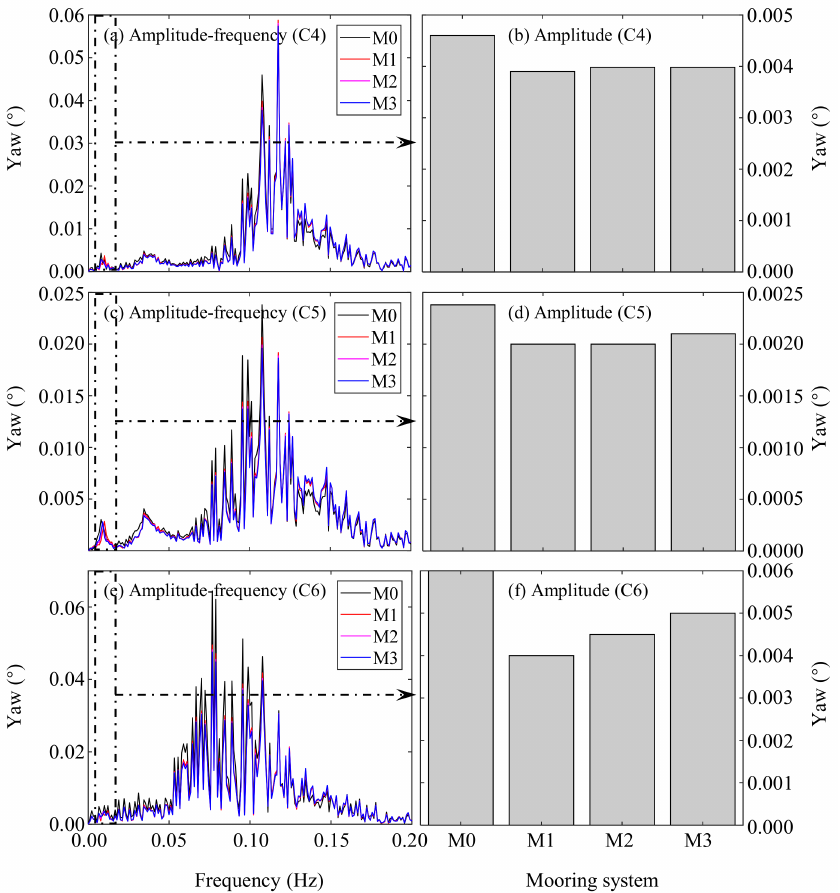
Figure 14. Wind turbine yaw movement in frequency domain with M0–3 when under: ( a ) amplitude- frequency (C4); ( b ) amplitude (C4); ( c ) amplitude-frequency (C5); ( d ) amplitude (C5); ( e ) amplitude- frequency (C6); ( f ) amplitude